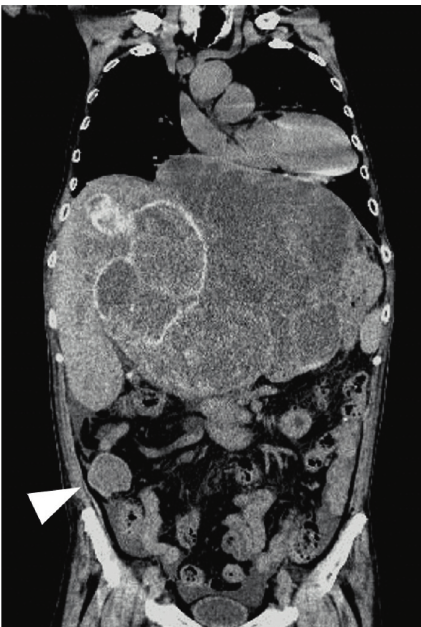
Figure 5: CT findings one month before death. Multiple metastases of GISTare found in the liver. A 40mm nodule is found in the ileocecal region (arrowhead). No tumor was found in both lungs.